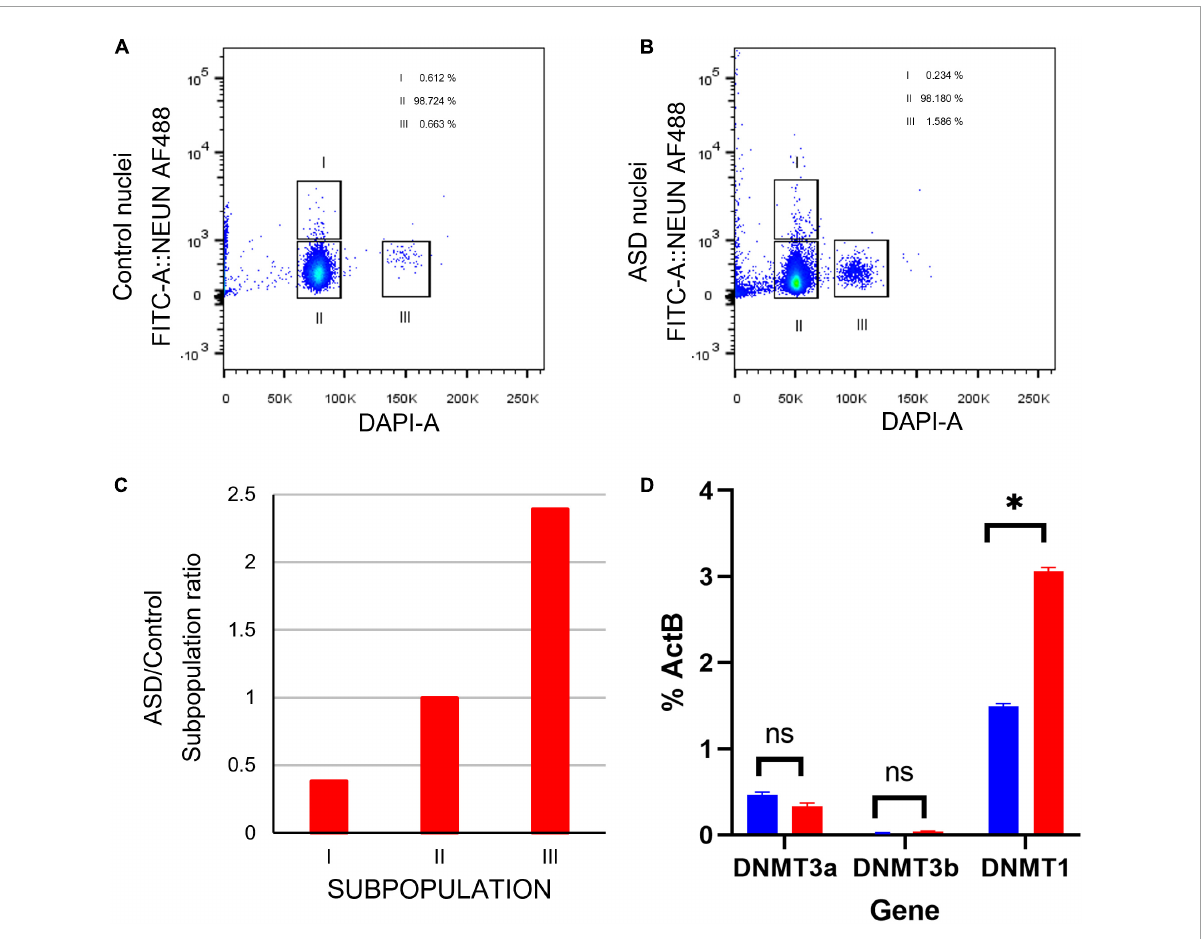
FIGURE8 Cell sorting by flow cytometry indicates a higher ratio of proliferating cells in postmortem SVZ tissue of ASD sample. (A) Fluorescence Activated Cell Sorting (FACS) of nuclei from in postmortem SVZ brain tissue of control (male, 42 years old) and (B) ASD (male, 43 years old) patients’ samples. Nuclei were purified by sucrose gradient and stained with Alexa488NeuN antibody and DAPI. Gates indicated as I select nuclei from mature neurons (Alexa488NeuN+DAPI+) and II select nuclei from glial cells (Alexa488NeuN-DAPI+), nuclei from these gates were sorted for expression analysis. Gate labeled as III select 2X DAPI+ Alexa488NeuN- glial dividing cells. (C) ASD/Control ratio of nuclei from the three cell types. (D) qPCR expression analysis of cell stage gene markers in postmortem SVZ brain tissue of control (male, 42 years old) and ASD (male, 43 years old) patients’ samples * p <